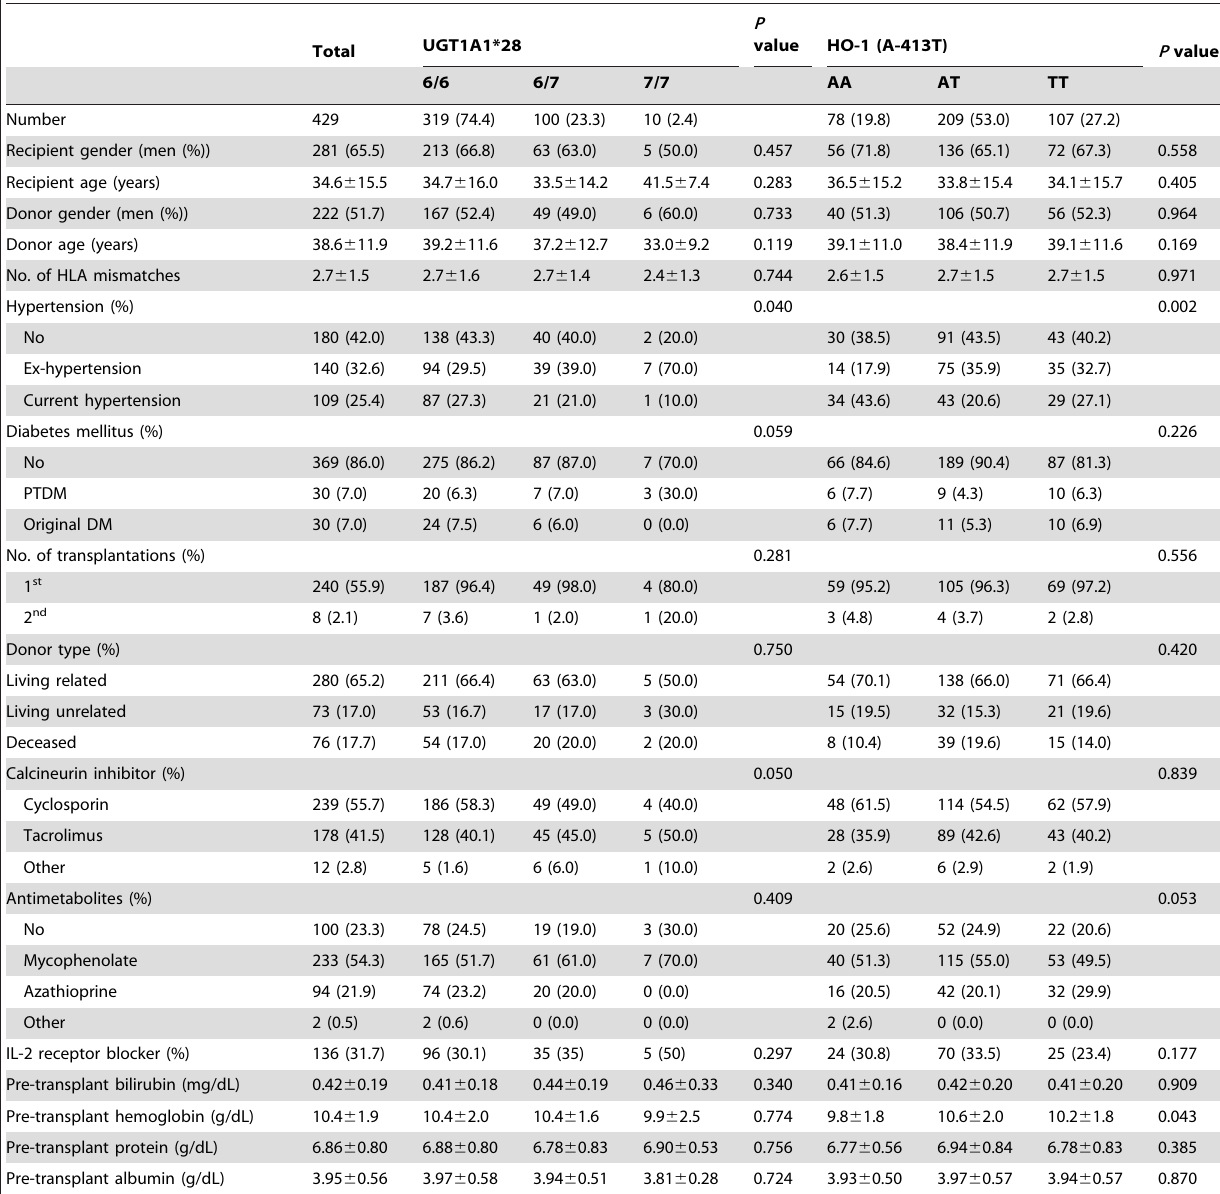
Table 1. Baseline